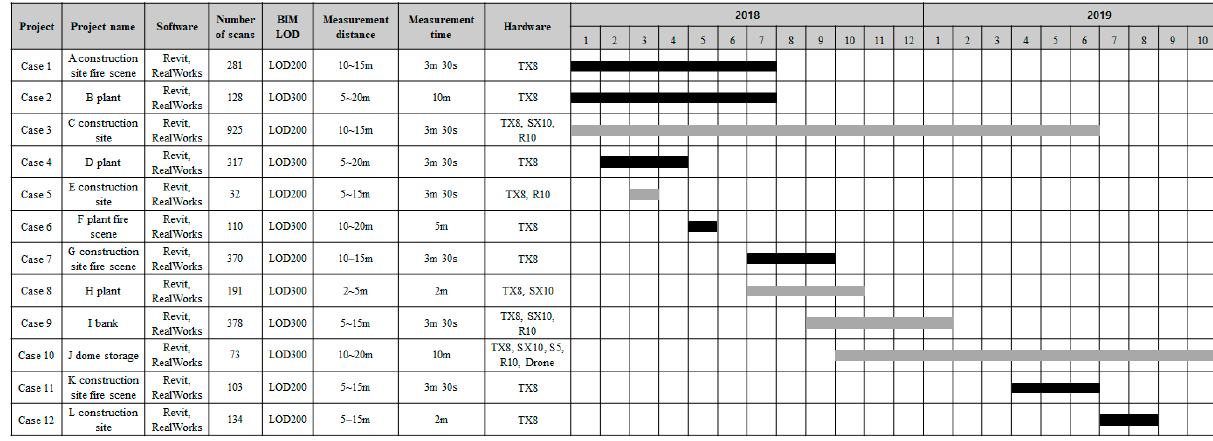
Figure 2. Project cases using TLS and